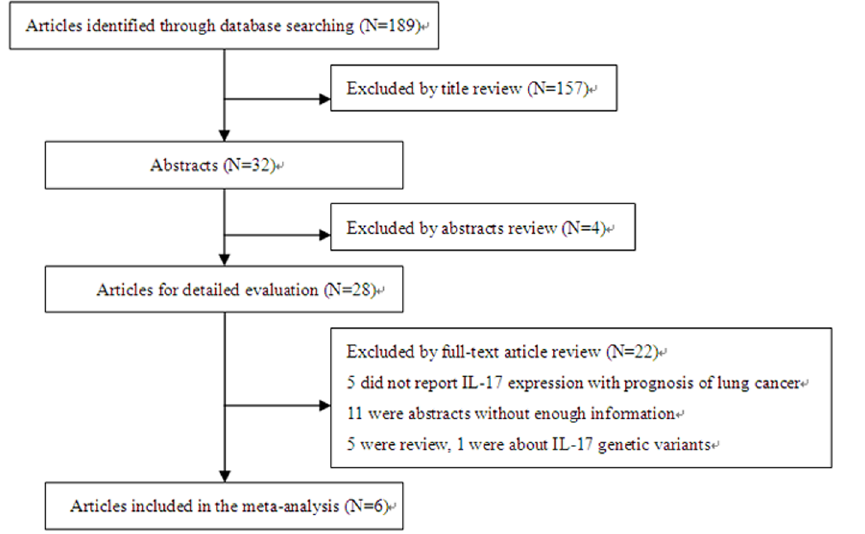
Fig 1. Flow chart of article selection for systematicreview and